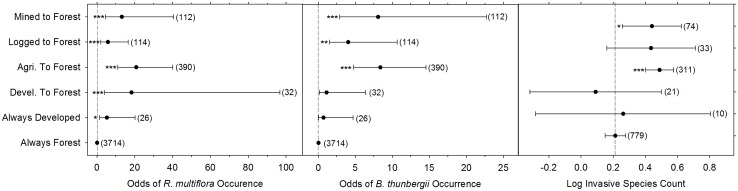
Plot-level odds of (a) R. multiflora and (b) B. thunbergii occurrence and (c) plot-level log odds of finding multiple invasive species.A total of 4388 10-m diameter plots with different land-use histories in a deciduous forest in eastern North America were included in this analysis except in the invasive species count analysis in which only plots with at least one invasive species were included (n = 792). The odds of occurrence for each invasive species in a given land-use category relative to always forested plots is given by each point with 95% confidence intervals. Sample sizes are given in parentheses. Among land-use histories, always forested plots (i.e. forested continuously since at least 1939) was used as the reference group and asterisks indicate a significant difference from always forested plots (*p < 0.05, **p < 0.01, ***p < 0.001).